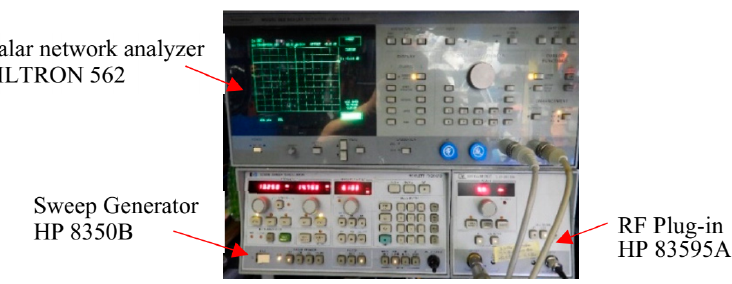
Figure 6. Sweep Generator (HP 8350B & 83595A) and Scalar network analyzer (WILTRON